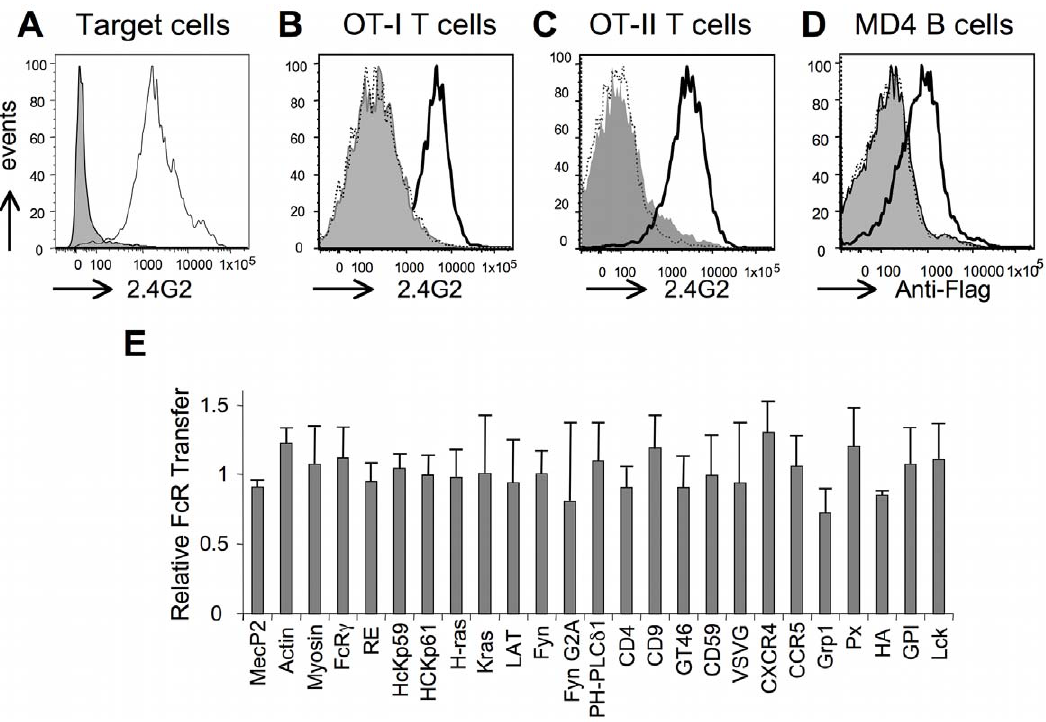
Figure 1. HEK-Fc c RII cells and their transient transfectants are targets of murine T and B cells in redirected trogocytosis experiments. A) HEK cells (grey histogram) or HEK-Fc c RII (white histogram) were stained with the anti-murine Fc c RII/RIII mAb 2.4G2 and analyzed by flow cytometry. B) HEK-Fc c RII cells were incubated 1 hour at 37 u C with activated OT-I T cells in the presence (white histogram) or absence (grey histogram) of the Y3 mAb triggering trogocytosis or in the presence of its isotype control (dashed line) before analysis by flow cytometry using anti- CD8 and anti-Fc c RII/RIII mAb. Shown are histograms of Fc c RII/RII staining on gated CD8 + T cells. C) as in B) except that OT-II T cells were used instead of OT-I cells and were detected using anti-CD4 mAb. D) As in B) except that MD4 B cells coated or not with anti- k chain mAb or its isotype control were used instead of OT-I T cells and that Fc c RII/RIII capture was detected with the anti-Flag Ab on gated B220 + B cells. E) As in B) except that capture of Fc c RII was analyzed after co-culture of OT-I T cells with HEK-Fc c RII that were transiently transfected 48 hours earlier with vectors encoding the indicated proteins fused to GFP. Capture of Fc c RII from HEK-Fc c RII transfected with the indicated constructs is shown as fold induction, which was calculated as indicated in the Materials and Methods section and normalized with fold induction obtained in cocultures with untransfected HEK- Fc c RII. Represented are means plus standard deviation from 3 independent experiments (no statistically significant differences emerged from student t-test